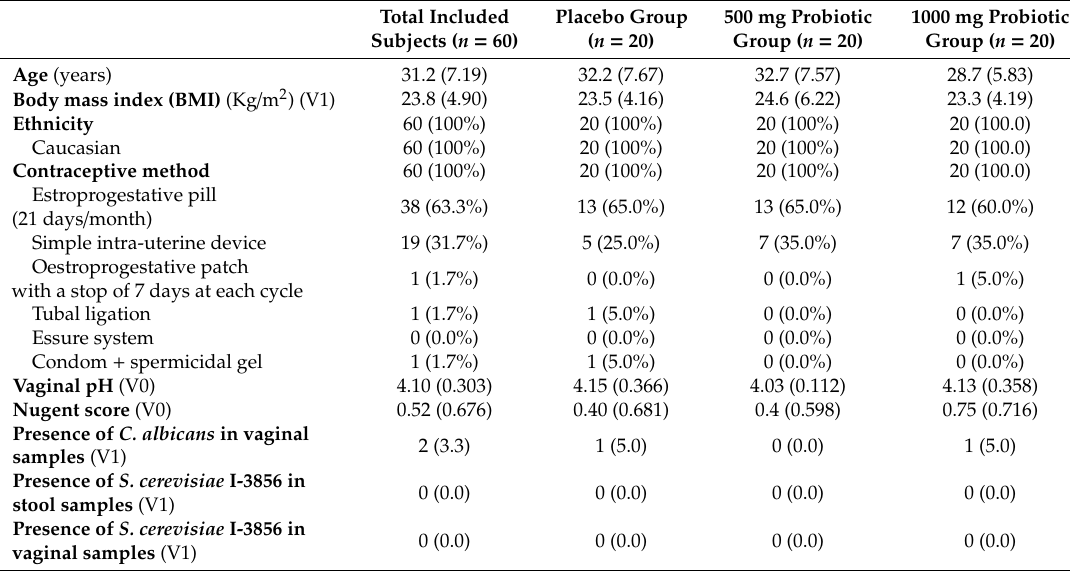
Table 3. Baseline characteristics of the study population.